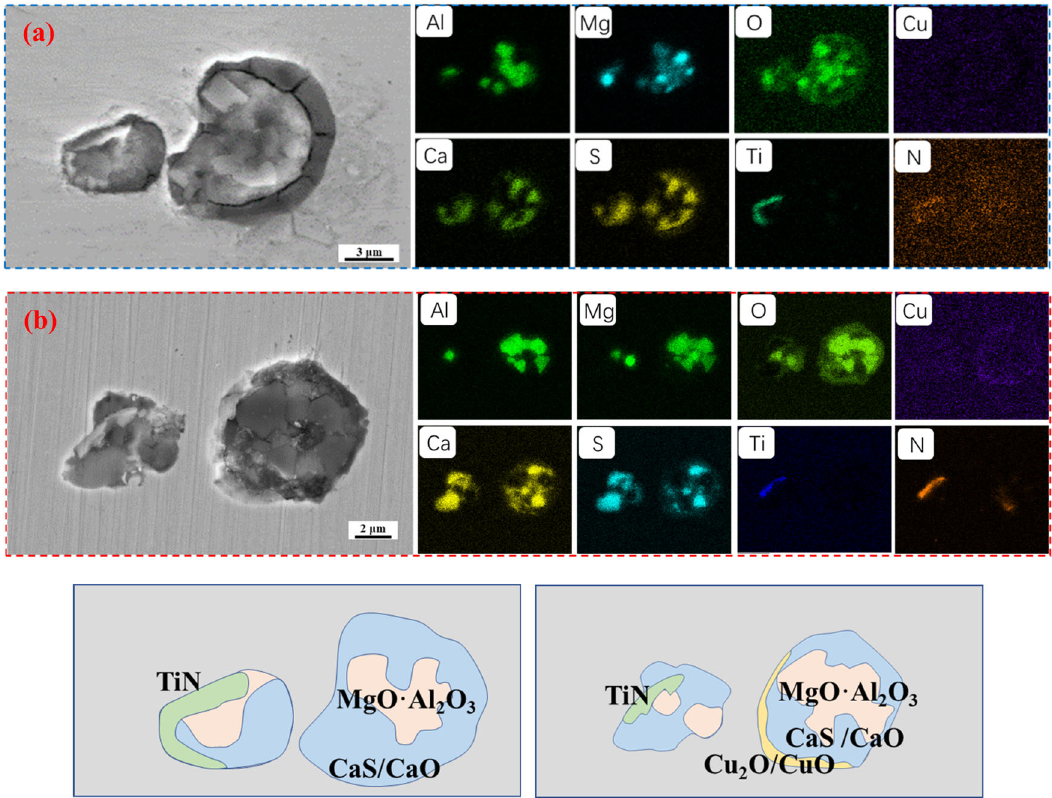
Fig. 10 Corrosion morphology and products of CaS/CaO – MgO – Al 2 O 3 inclusion with 10 s water immersion. a Before thinning and b after thinning.